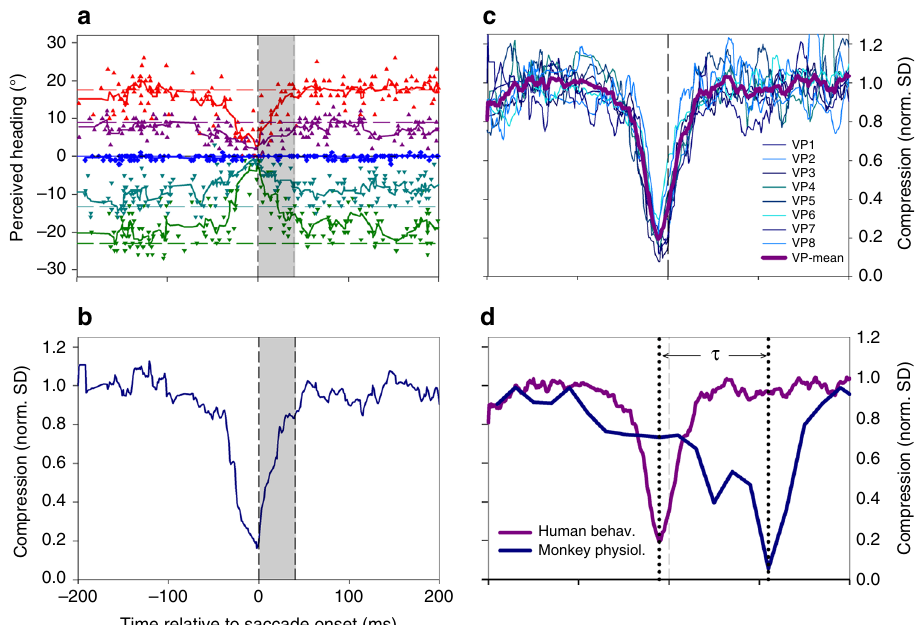
Fig. 9 Time course of compression of perceived and decoded heading. a Responses from one example subject (VP01). Symbols represent data from single trials: upward pointing triangles for heading to the right (magenta: +15°, red: +30°), downward pointing triangles for heading to the left (dark cyan: − 15°, green: − 30°), and circles for heading straight ahead (blue, 0°). Solid lines represent running means of fi ve consecutive samples each, assigned to the central sample value. Dashed lines show the performance for the same experiment during continuous fi xation. b Compression, de fi ned as the normalized standard deviation of the fi ve time-courses of perceived heading for the same subject as a . Maximum compression as indicated by the minimum value of the normalized standard deviation was observed just prior to saccade onset, i.e., at t = − 1 ms. c Time course of heading compression from the eight subjects (thin blueish lines) and the average compression of perceived heading (thick purple curve). d The neurophysiological data (blue data curve) followed the behavioral data (purple data curve) by τ = 116 ms, as determined from cross-correlation of the two time-courses. This value of τ is consistent with visual response latencies as summarized in ref.